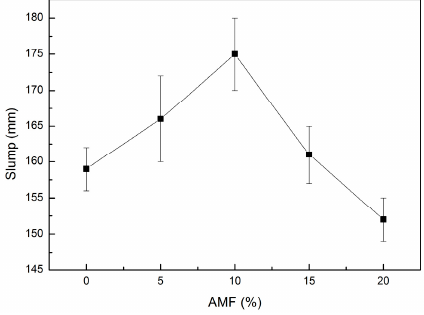
Figure 2. E ff ect of AMF content on slump of fresh concrete. Figure 2. Effect of AMF content on slump of fresh concrete. Figure 2. Effect of AMF content on slump of fresh concrete.